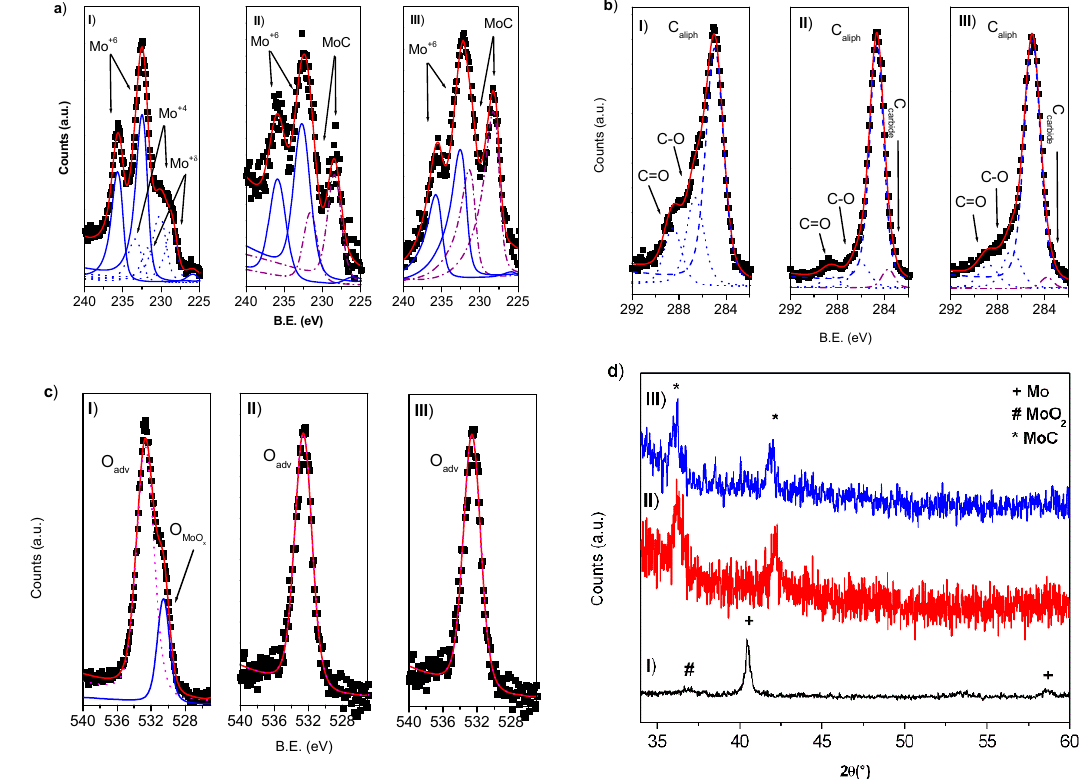
Figure 4. ( a ) XPS Mo 3d region spectra; ( b ) XPS C1s region spectra; ( c ) XPS O1s region spectra and ( d ) XRD spectra of nanoparticles obtained by laser ablation of Mo in water (I), acetone (II) and toluene (III). In XPS spectra blue lines are referred to MoO 3 , blue dotted lines to Mo + 2 and Mo + δ and purple dash-dotted lines to MoC species, respectively.